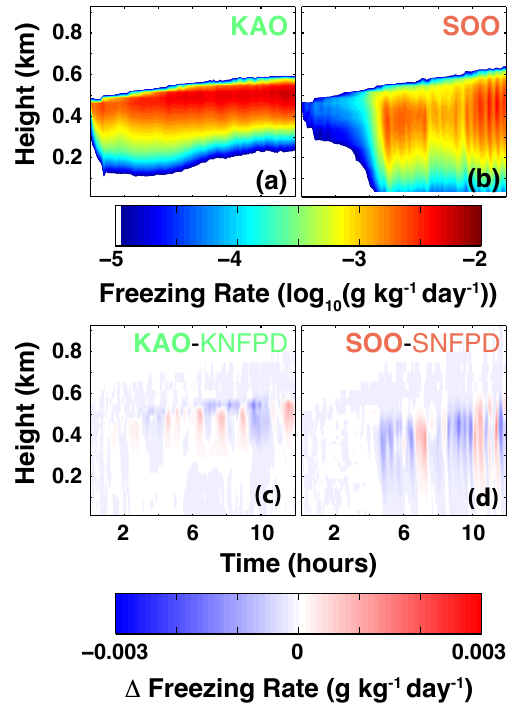
Fig. 4. Domain-averaged time-height cross-sections of immersion freezing rates from the KAO (a) and SOO (b) simulations, and the differences between the domain-averaged rates from those simula- tions and those from the KNFPD (c) and SNFPD (d) (without freez- ing point depression)